Question: Express in one sentence what the figure is showing.
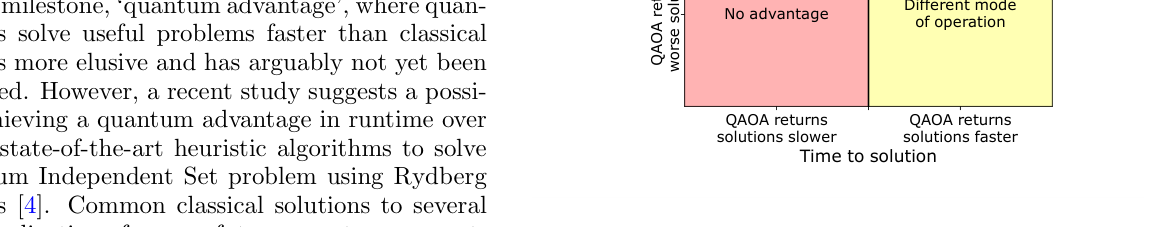
Answer: Locus of quantum advantage over classical algo- rithms. A particular classical algorithm may return some so- lution to some ensemble of problems in time TC (horizontal axis) with some quality CC (vertical axis). Similarly, a quan- tum algorithm may return a different solution sampled in time TQ, which may be faster (right) or slower (left) than classical, with a better (top) or worse (bottom) quality than classical. If QAOA returns better solutions faster than the classical, then there is clear advantage (top right), and conversely no advantage for worse solutions slower than the classical (bot- tom left).